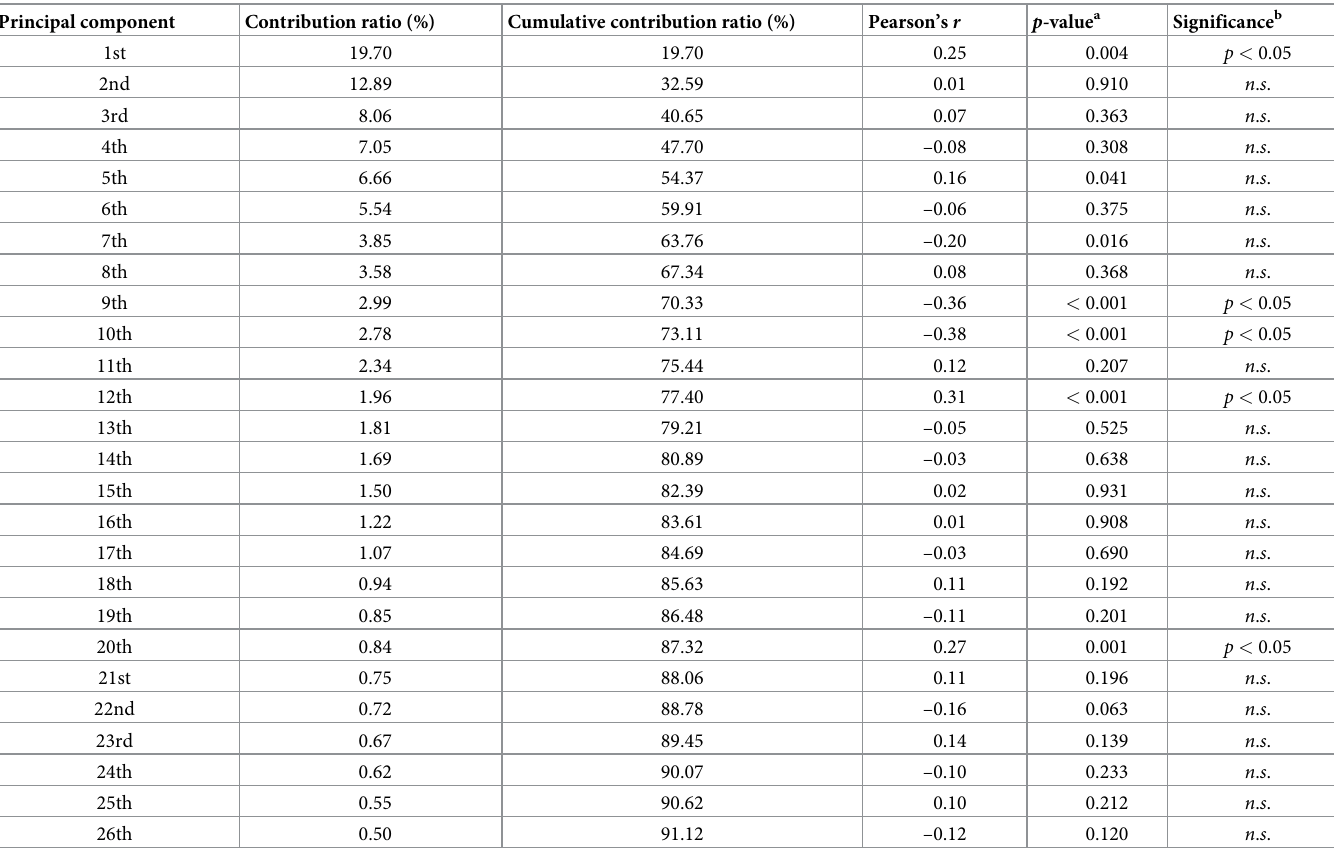
Table 1. Principal component analysis (PCA) of the homologous polygon models, Pearson’s r s between perceived ages, and principal component (PC) scores. Principal